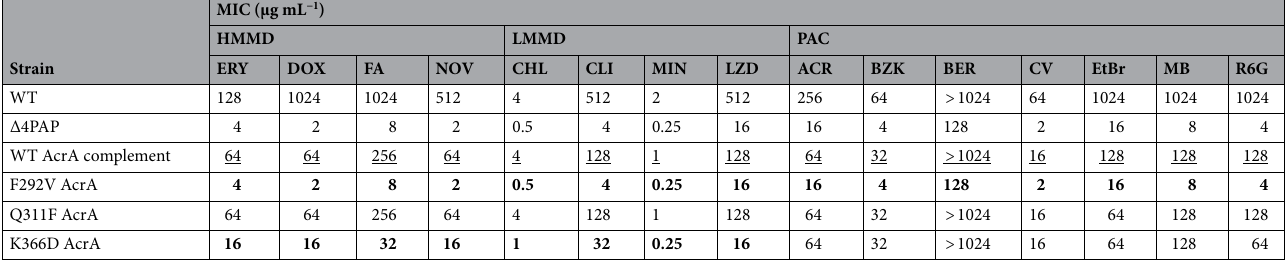
Table 1. Antimicrobial susceptibility of the Salmonella Typhimurium SL1344 Δ4PAP strain complemented with F292V, Q311F or K366D AcrA to drugs with different physicochemical characteristics. Underlined values highlight values for the Δ4PAP strain complemented with wild type AcrA (WT complement). Bold values are at least two-fold or more different than the parent strain. HMMD, high-molecular-mass drug; ERY, erythromycin; DOX, doxorubicin; FA, fusidic acid; NOV, novobiocin; LMMD, low-molecular-mass drug; CHL, chloramphenicol; CLI, clindamycin; MIN, minocycline; LZD, linezolid; PAC, planar aromatic cation;